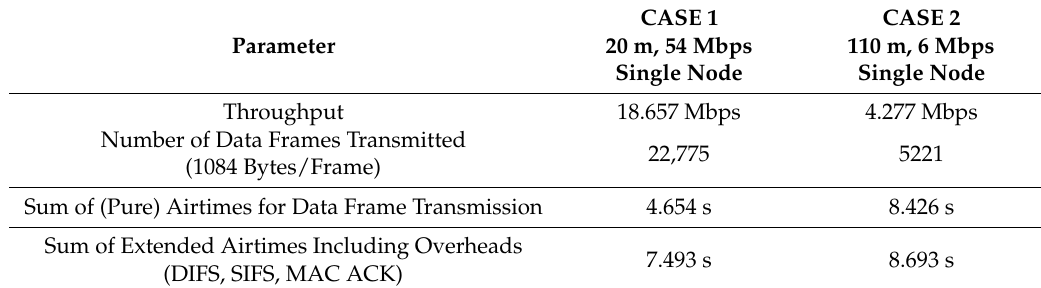
Table 1. Airtime Analysis (TCP Bulk Download Traffic, 802.11g Simulation for 10